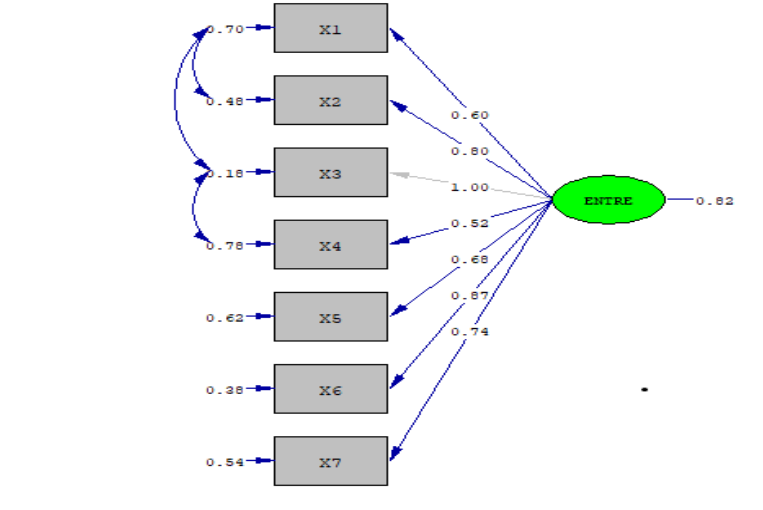
Figure 3. Measurement model of entrepreneurial spirit of students.